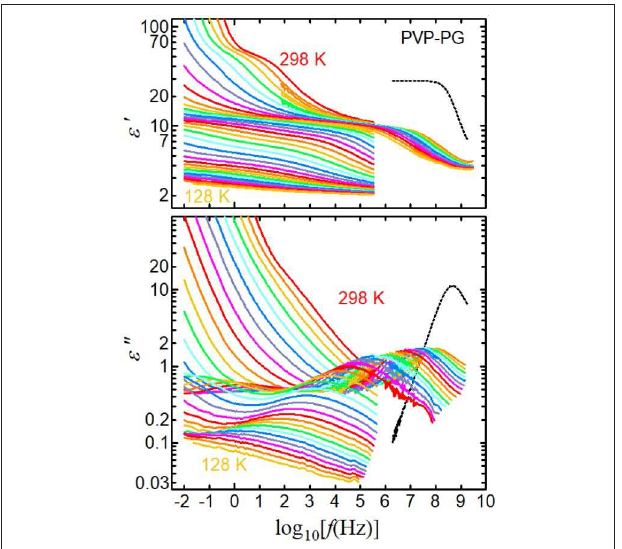
FIGURE 1 | Real ( ε ′ ) and imaginary ( ε ′′ ) parts of complex permittivity as a function of frequency for the 65 wt% PVP–PG mixture at 298–128K in steps of 5K. Black dotted curves are the spectra of pure PG at 298